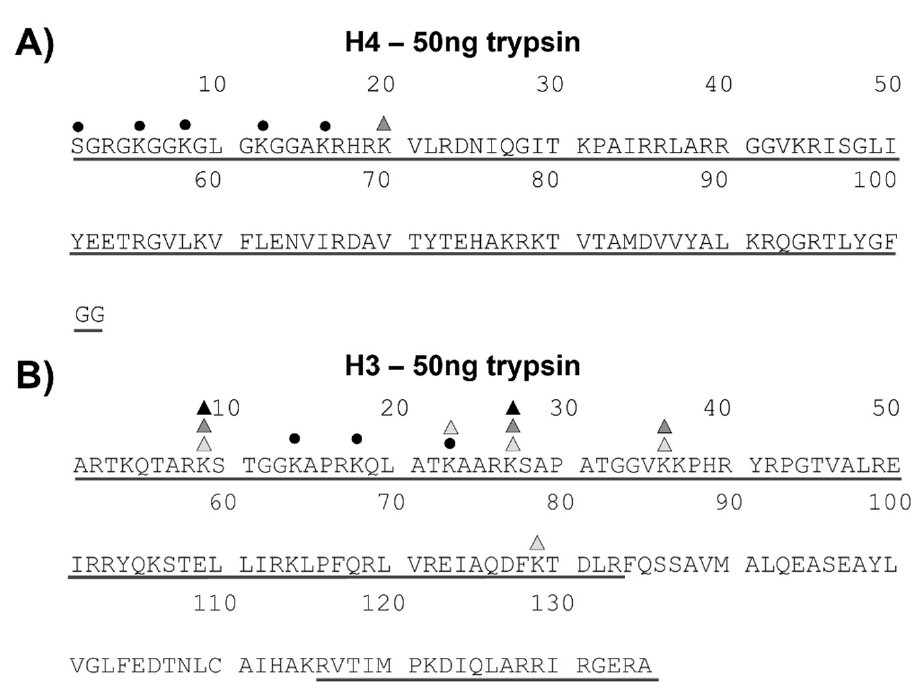
Figure 2. MALDI-MS- and LC-MS/MS-derived histone mass mapping with the identified modifica- tions. The underlined regions represent the covered sequences obtained by MALDI-MS and/or by LC-MS/MS analyses. Black circles represent acetylation. Light grey, dark grey, and black triangles are for methylation, di-methylation, and tri-methylation, respectively. ( A ) Histone H4 mass mapping obtained by incubating 4 µ g of chicken core histones with 50 ng of trypsin in the limited proteolysis protocol. ( B ) Histone H3 mapping obtained from the reaction of 4 µ g of chicken core histones with 50 ng of trypsin in the limited proteolysis procedure.